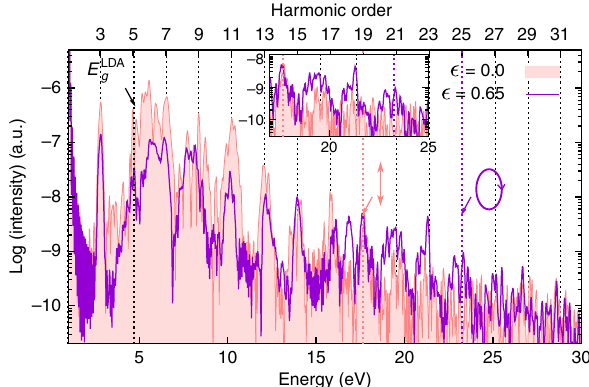
Fig. 5 Ellipticity-based HHG cutoff extension. Computed HHG spectra from bulk MgO for linearly polarized and elliptically polarized ( ϵ = 0.65) driving pulses. In both cases, the major axis of the polarization ellipse along the Γ K . The dashed lines indicate the position of the cutoff energy ( E c ). The inset shows a zoom into the spectral region around the extended energy